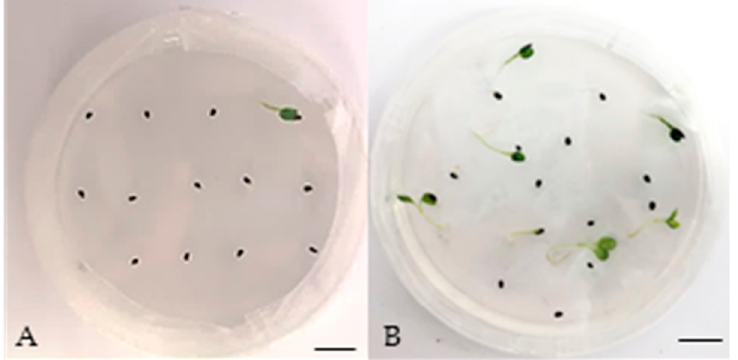
Figure 2. Sideritis raeseri subsp. attica seeds’ germination in Petri dishes containing half-strength Murashige and Skoog media (MS) at 20.0 °C under 16.0 h light/8.0 h darkness: ( A ) after 9.0 days and ( B ) after 30.0 days of incubation. Bars represent a length of 1.0 cm.